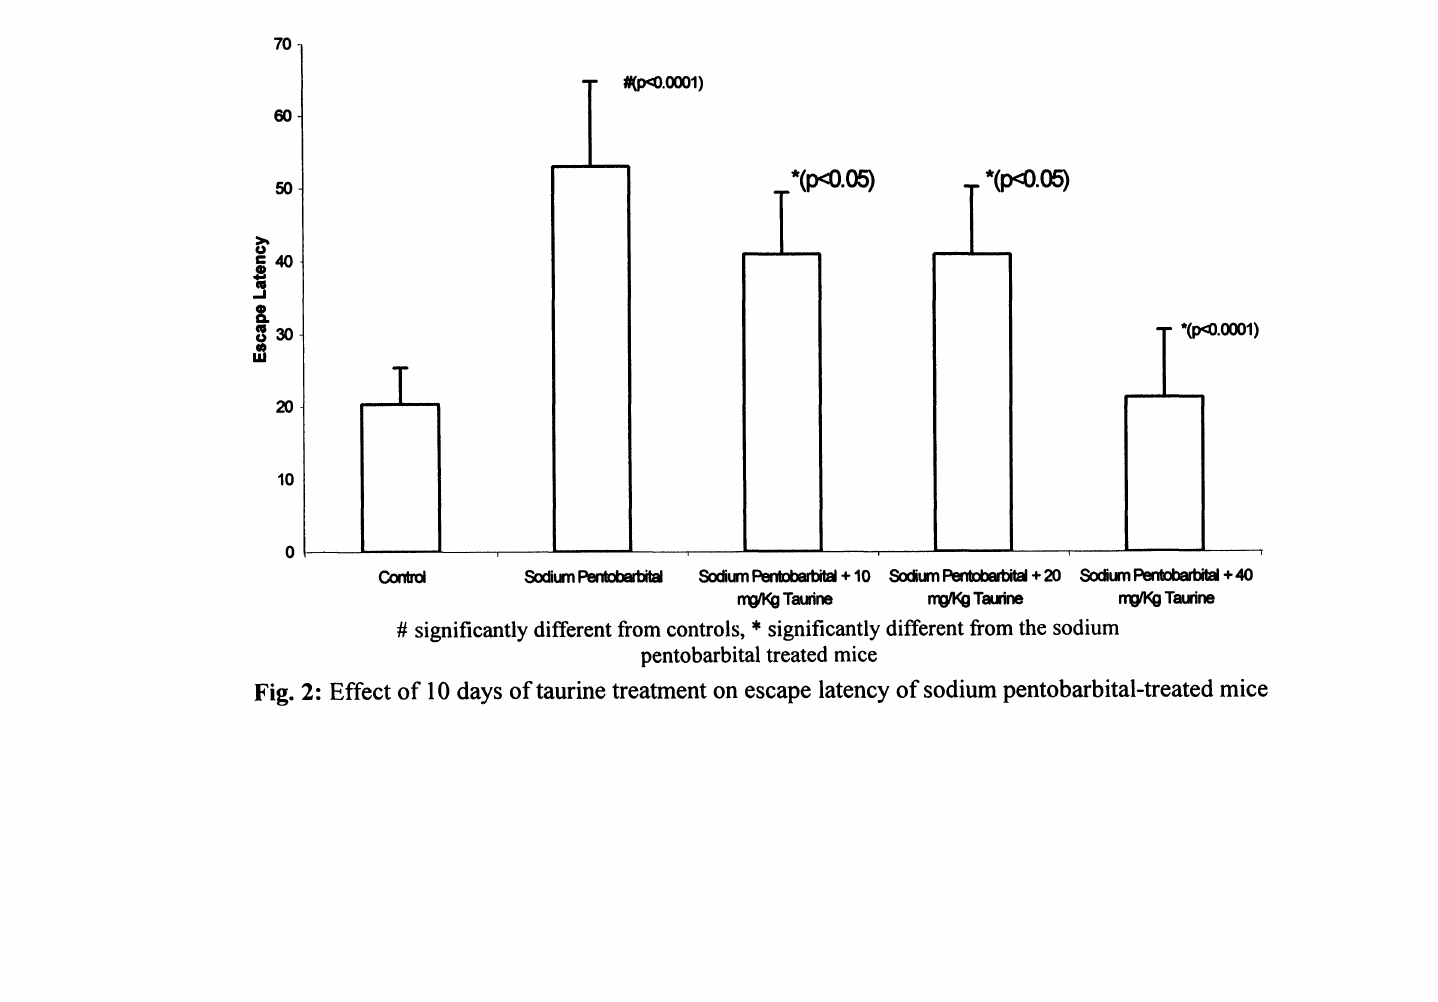
Fig. 1" Effect of 10 days of taurine treatment on stepdown latency in sodium pentobarbital-treated mice